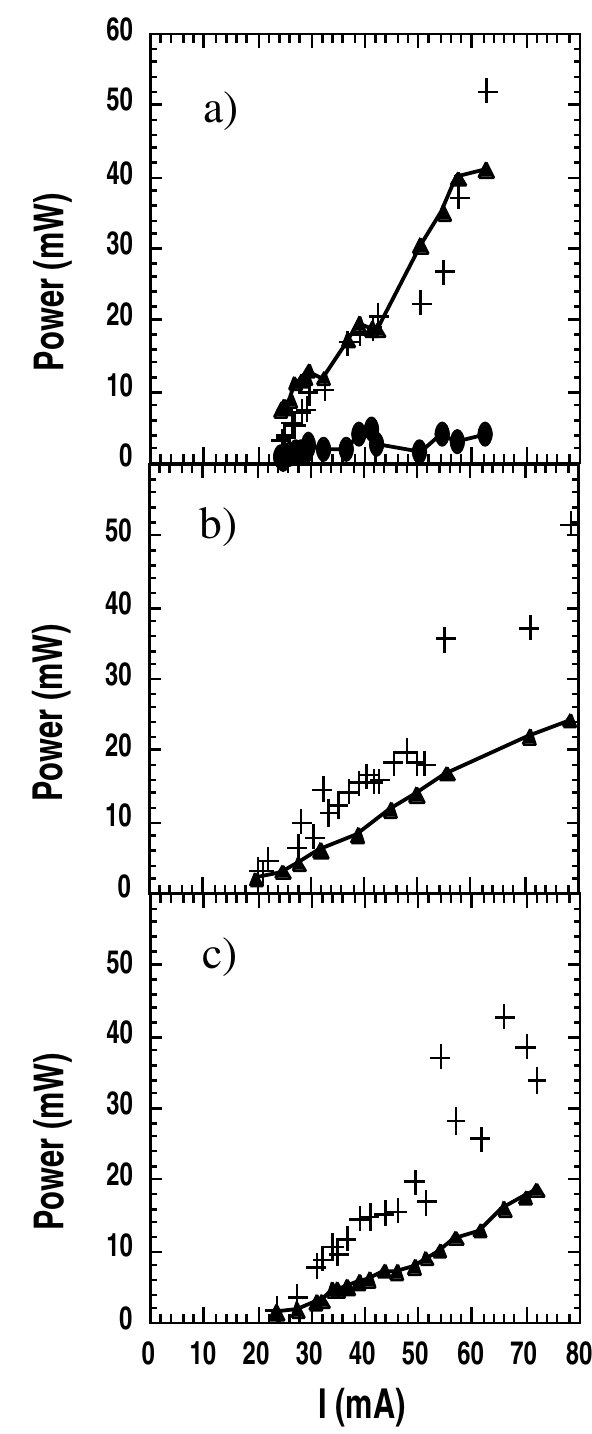
FIG. 6. Equilibrium laser power measurements (+) vs current and Renieri limit analysis performed by comparing the bunch length measured under laser heating either ( (cid:2) ) with the corresponding value measured in the absence of a laser or ( (cid:3) ) with the zero current value. (a) V 3 (cid:6) 10 (cid:3) 4 , L (cid:1) 1% , and (cid:1) 0 1 : 7 (cid:6) 10 (cid:3) 4 , L (cid:1) 1% , and (cid:1) 0 T (cid:1) 1 : 7 (cid:6) 10 (cid:3) 4 , L (cid:1) 1 : 13% , and (cid:1) 0